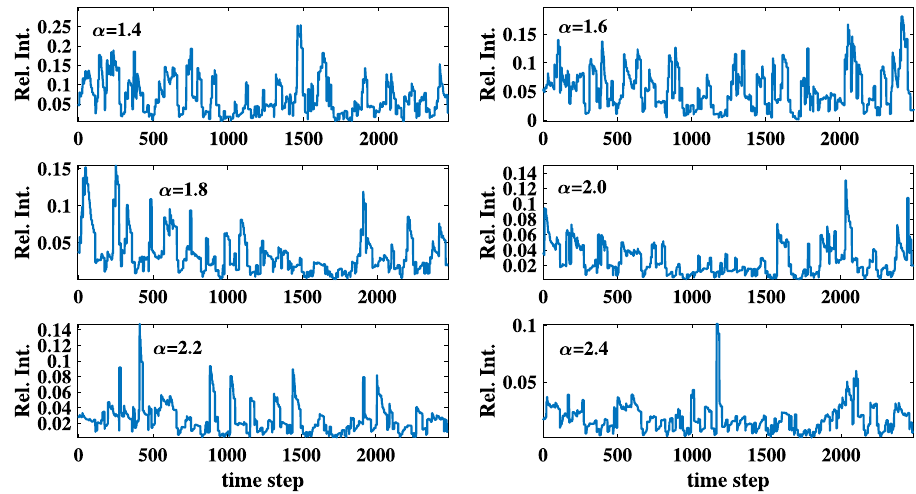
Figure 6. Simulated light curves of the nano-are emission model for τ d = 10 , p f = 0.2 , and different α values.